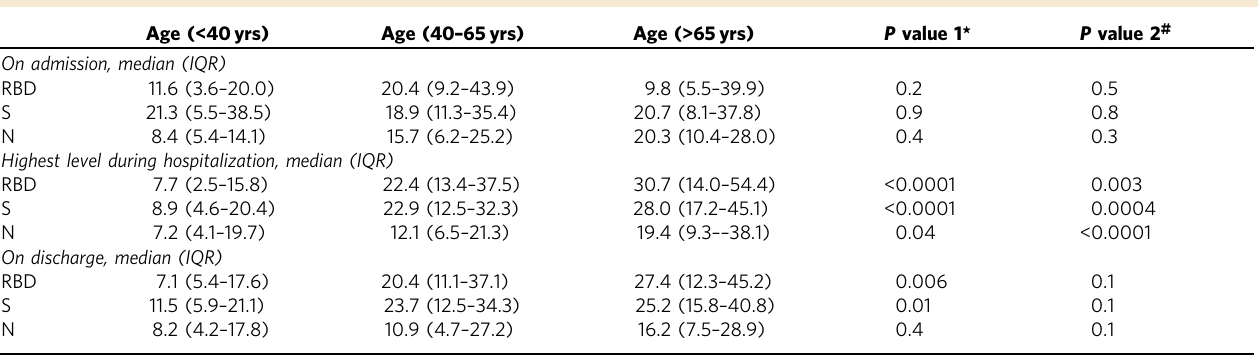
Table 2 SARS-COV-2-speci fi c IgG levels in COVID-19 patients according to